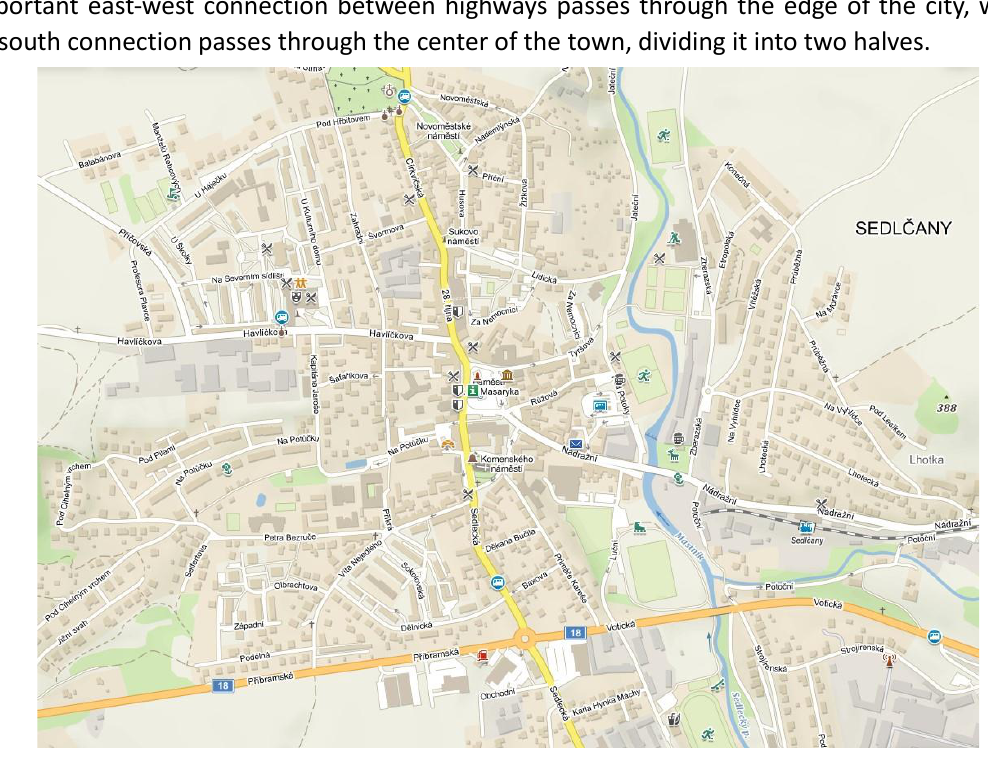
Figure 1: The map of Sedlčany (source: authors with use of